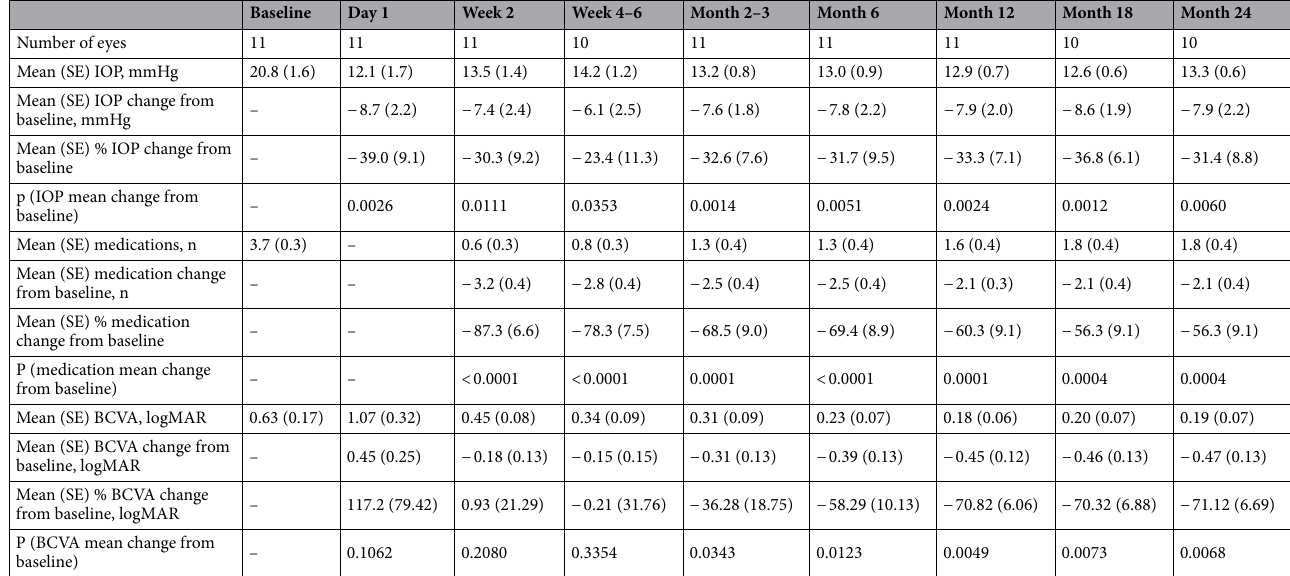
Table 3. Intraocular pressure, medication, and visual acuity data at each time point in eyes with angle-closure glaucoma (n = 11). BCVA best-corrected visual acuity, IOP intraocular pressure, logMAR logarithm of the minimum angle of resolution, mmHg millimeters of mercury, SE standard